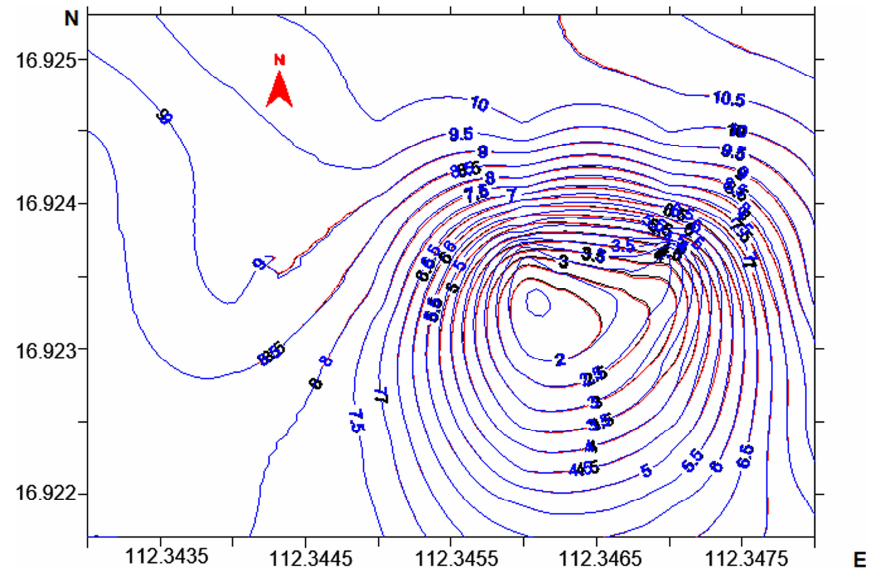
Figure 10. Underwater topography changes in the newborn sandbank under average wave action in a strong wave direction lasting for 1 month. (The red lines are the initial underwater topography, and the blue lines are the new underwater topography after 1 month of wave action).